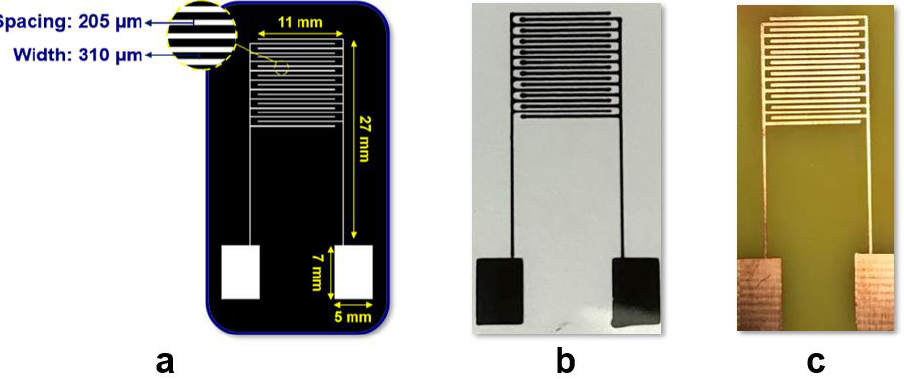
Figure 1. ( a ) Optimized Design ( b ) Carbon ink-based IDE printed on glass slide ( c ) Photolithography-based DLW IDE on a copper-cladded FR4 board.